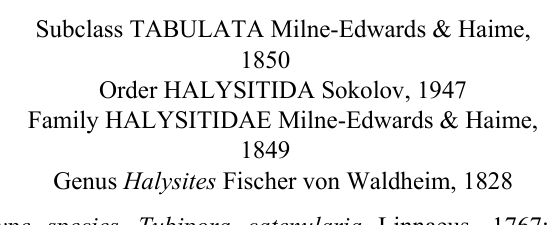
Derivation of name . After Gaojiang village, Meitan County, northern Guizhou Province where the type locality is situated.